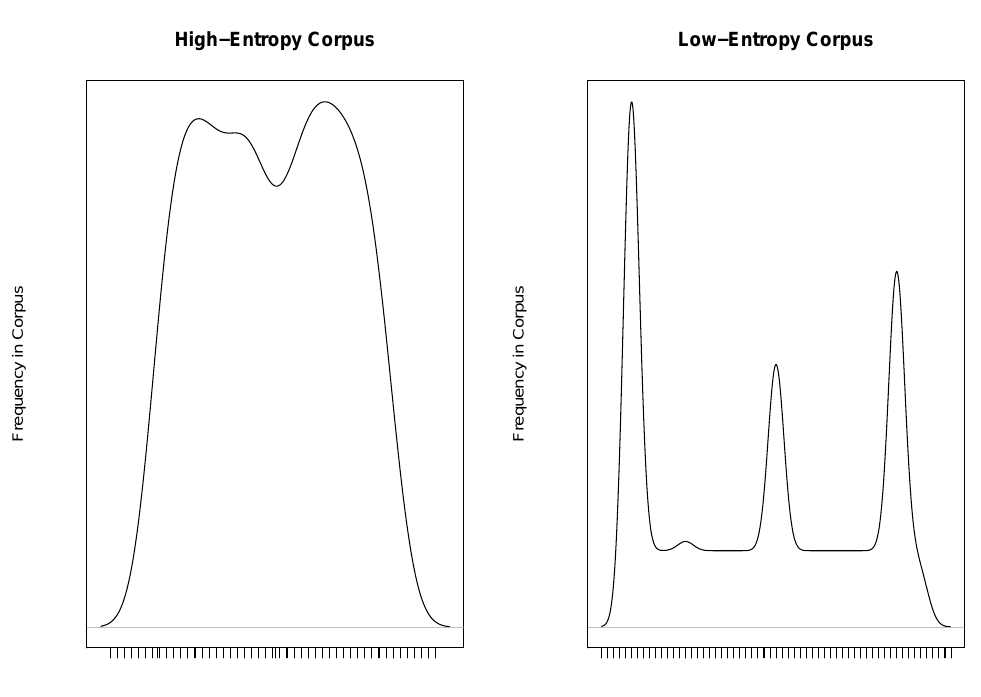
Figure 1: Hypothetical distributions of term frequency in high- and low-entropy